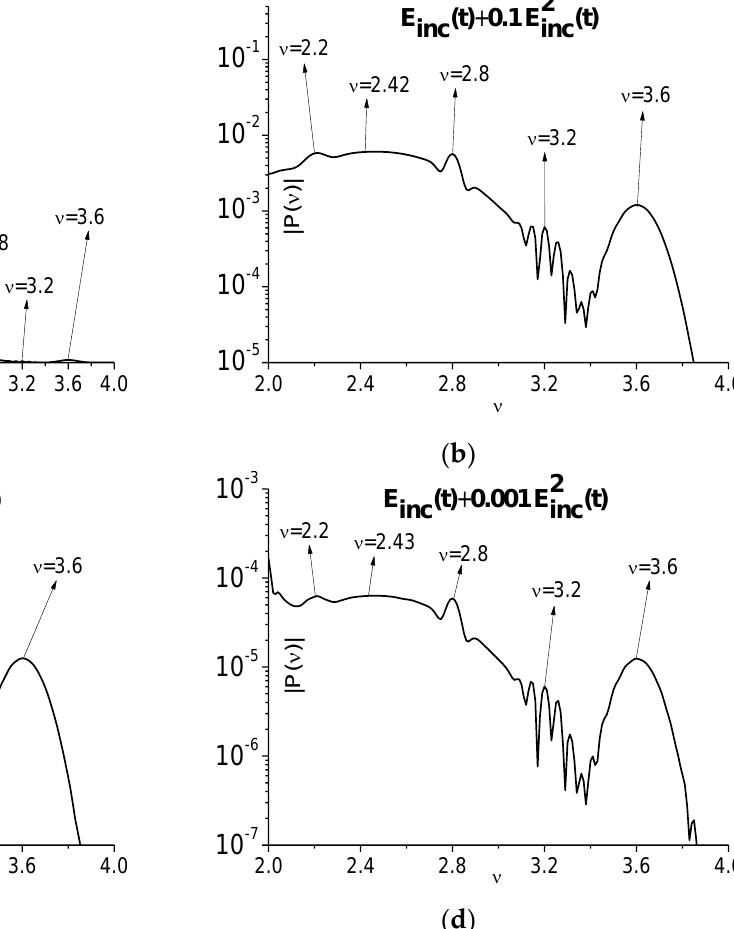
( ) E t with (2) χ = 0.1 ( a , b ) and 0.01 ( c ), 0.001 ( d ) Figure 5. Fourier spectrum of the signal _ tran norm ν = [0.2, 4]. ( a ), and [2.0, 4.0] ( b – d ). in the frequency ranges χ E t computed with (2) The spectrum of the signal ( ) = 0.01 and 0.001 is dl tran norm ν = [2.0, 4.0] in Figure 5c,d, respectively. The spectral shown in the frequency range ν maxima at the frequencies = 2.2, 2.43, 2.8, 3.2, 3.6 are preserved in the transmitted χ . spectrum at a decreasing value of (2) dl The evolutions of the spectral amplitude modulus | at the fre- ( d ) quencies ν = (0.8, 1.6), (1.2, 2.4), (1.4, 1.8), (1.8, 3.6) depicted in Figure 6a–d (black and red χ lines, respectively) for (2) = 0.1 show a high correlation: the correlation coefficients are E t with ( 2 )  = 0.1 ( a , b ) and 0.01 ( c ), 0.001 ( d ) in () Figure 5. Fourier spectrum of the signal dl Figure 5. Fourier spectrum of the signal E tran _ norm ( t ) with χ ( 2 ) =0.1 ( a , b ) and 0.01 ( c ), 0.001 ( d ) in the t r anno r m _ χ frequency ranges ν = [0.2, 4]. ( a ), and [2.0, 4.0] ( b – d ). also close to unity. The same result is valid for (2) = 0.01 and 0.001. the frequency ranges  = [0.2, 4]. ( a ), and [2.0, 4.0] ( b – d ). dl